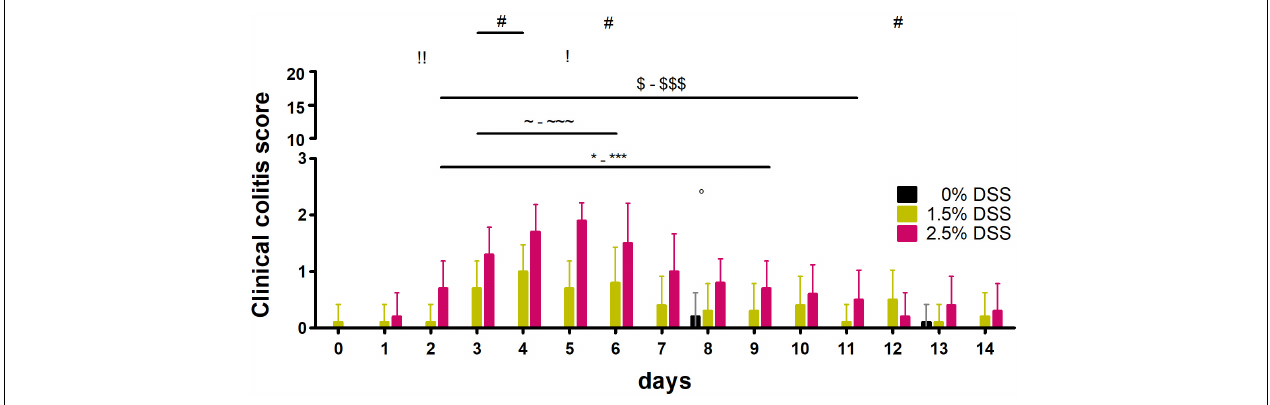
FIGURE 2 | Results of the clinical colitis score. Clinical colitis score of all three groups of the DSS-induced colitis model ( n = 10 animals in each group). Comparison to d0: one way RM ANOVA + Dunnett’s post hoc test; ◦ : 0% [ F ( 14 , 126 ) = 1.678, p = 0.0682; d8: adj. p = 0.0154], ∼ - ∼∼∼ : 1.5% [ F ( 14 , 126 ) = 4.094, p < 0.0001; d3: adj. p = 0.0428, d4: adj. p = 0.0004, d5: p = 0.0428, d6: adj. p = 0.0104], *-***: 2.5% [ F ( 14 , 126 ) = 14.08, p < 0.0001; d2: adj. p = 0.0189, d3-6: adj. p < 0.0001, d7: adj. p = 0.0002, d8: adj. p = 0.0045, d9: p = 0.0189]. Comparison between the different groups: Kruskal-Wallis Test + Dunn’s post hoc test; #: 0% vs. 1.5% (d3: adj. p = 0.0237, d4: adj. p = 0.0101 and d6: adj. p = 0.0259), $-$$$: 0% vs. 2.5% (d2: p = 0.0015, d3-d6: p < 0.0001, d7: adj. p = 0.0008, d9: p = 0.0033, d10: p = 0.0154, d11: adj. p = 0.018), !, !!: 1.5% vs. 2.5% (d2: p = 0.0086, d5: p =